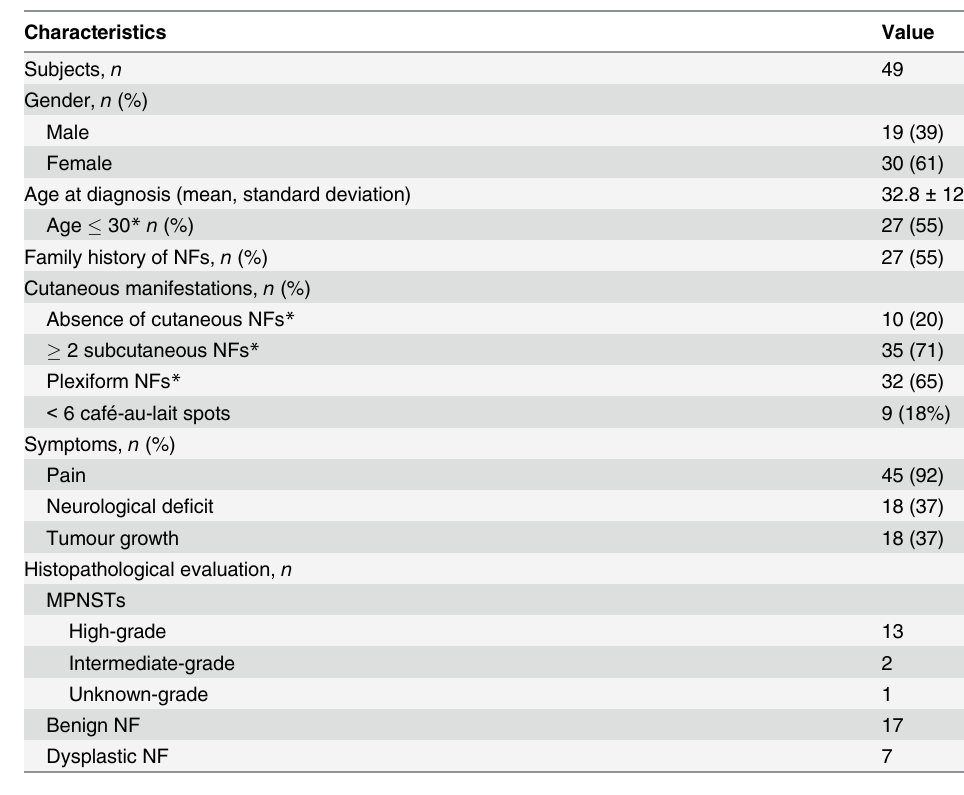
Table 1. Clinical